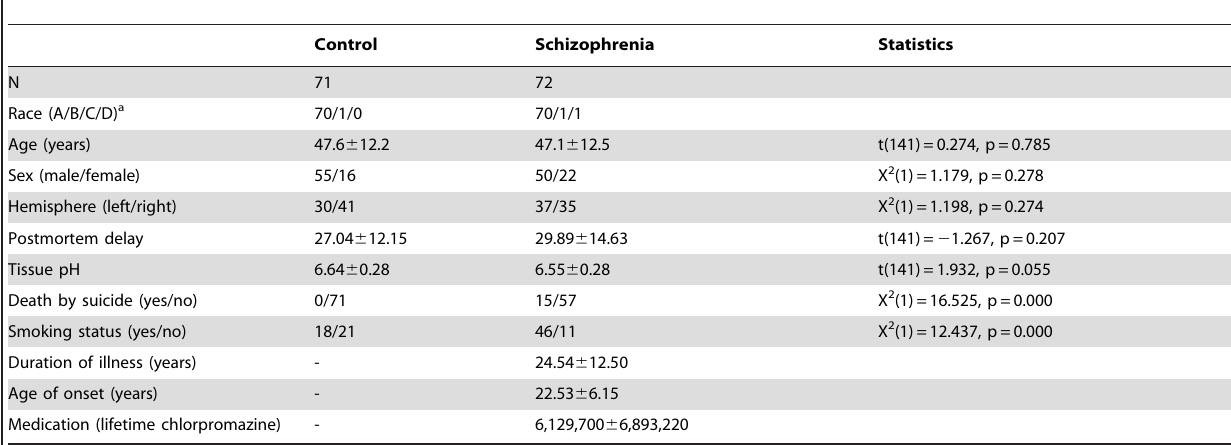
Table 4. Demographic and clinical variables of the combined SMRI and NSW TRC